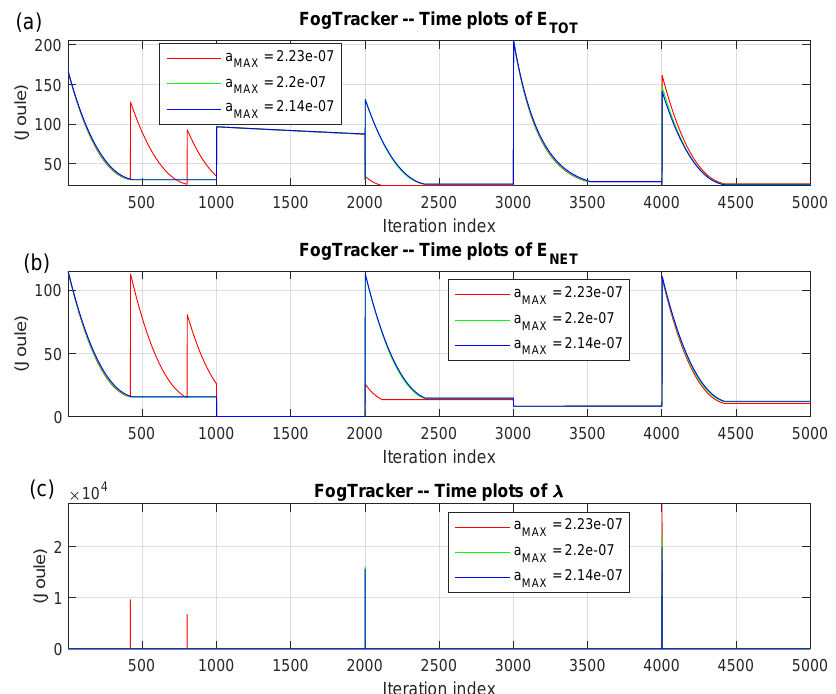
Figure 9. Tracking performance under DAG3 for three values of the speed-factor a MAX . ( a ) time behaviors of the total energy E TOT ; ( b ) time behaviors of the corresponding network energy E NET ; and ( c ) time behaviors of the λ